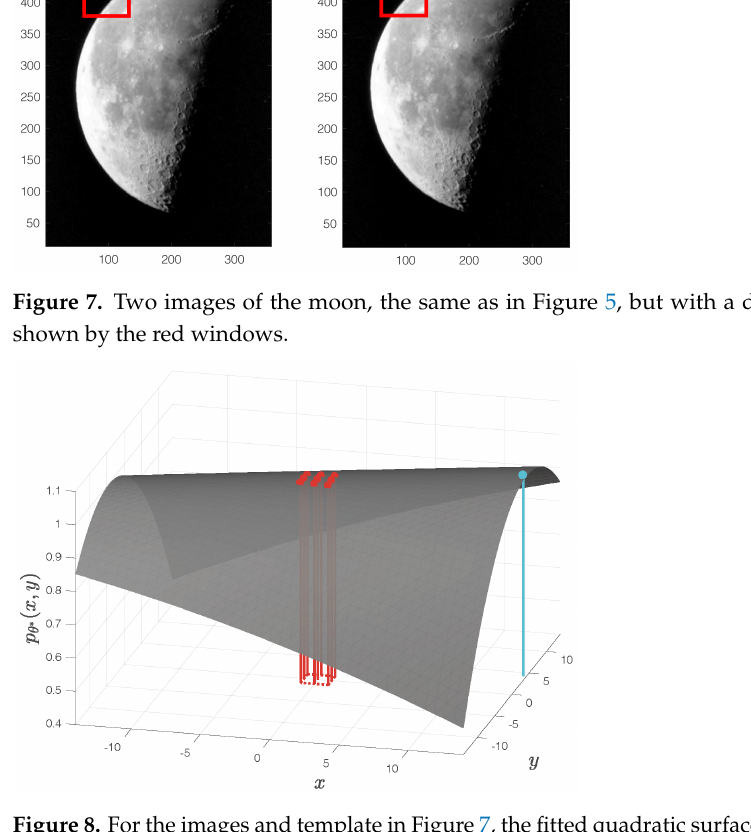
Figure 8. For the images and template in Figure 7, the fitted quadratic surface has a maximum located at ( x ∗ , y ∗ ) = ( 13.76,4.28 ) , as shown by the cyan dot on the surface. The red dotted lines on the bottom plane delimit the square area of the one-pixel vicinity around the pixel-level cross-correlation peak. As a subpixel refinement, the maximum of the fitted surface should satisfy | x ∗ | < 1 and | y ∗ | < 1, which is not the case in this example. See [16] for the details of this